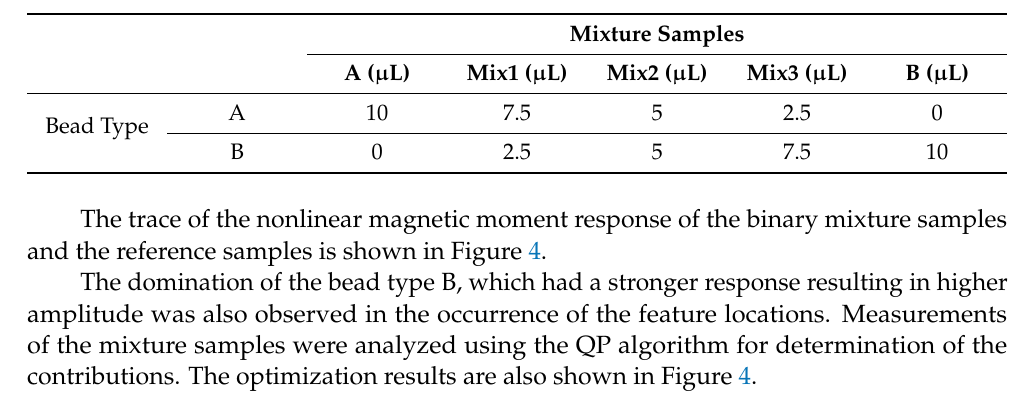
Table 2. Amount of bead types used for the preparation of the reference samples (A and B) and the mixture samples Mix1 to Mix3. Bead type A resembles 1 µ m Nanomag/SynomagCLD, and bead type B resembles 1 µ m